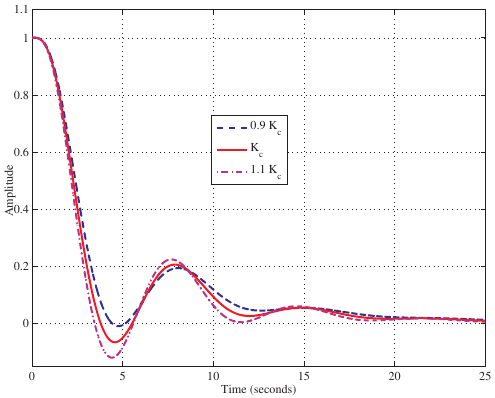
Figure 12. Control variable in the first example for different values of K c .